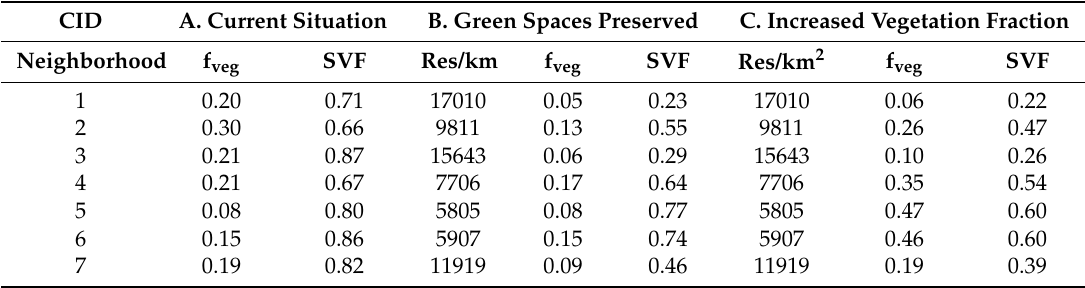
Table A2. Values used for the SVF and the vegetation fraction for the urban planning strategies in urban district CID. In addition, the residence density is indicated. Neighborhoods are displayed in Figure 3.